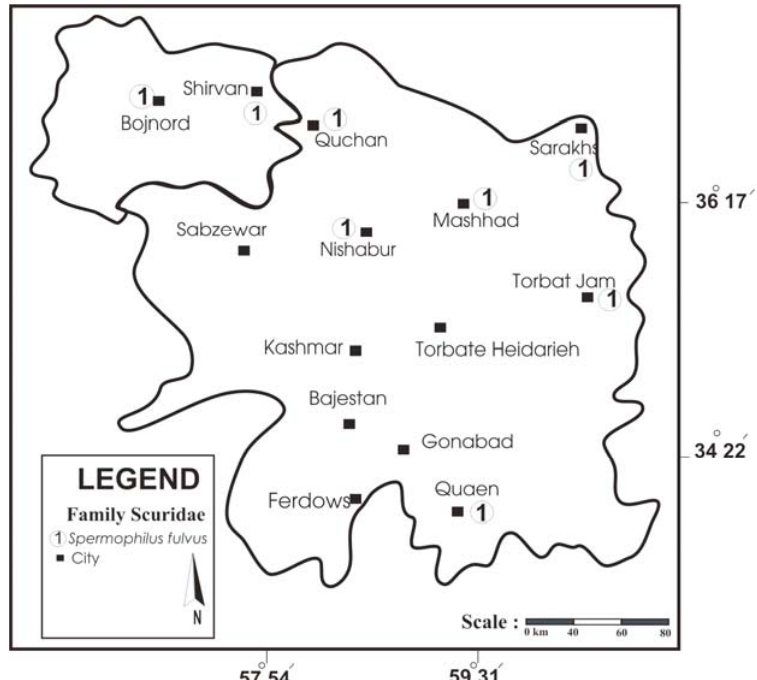
F IG . 1. - Map of northeastern Iran with collecting sites for Spermophilus fulvus , indicated with number 1.